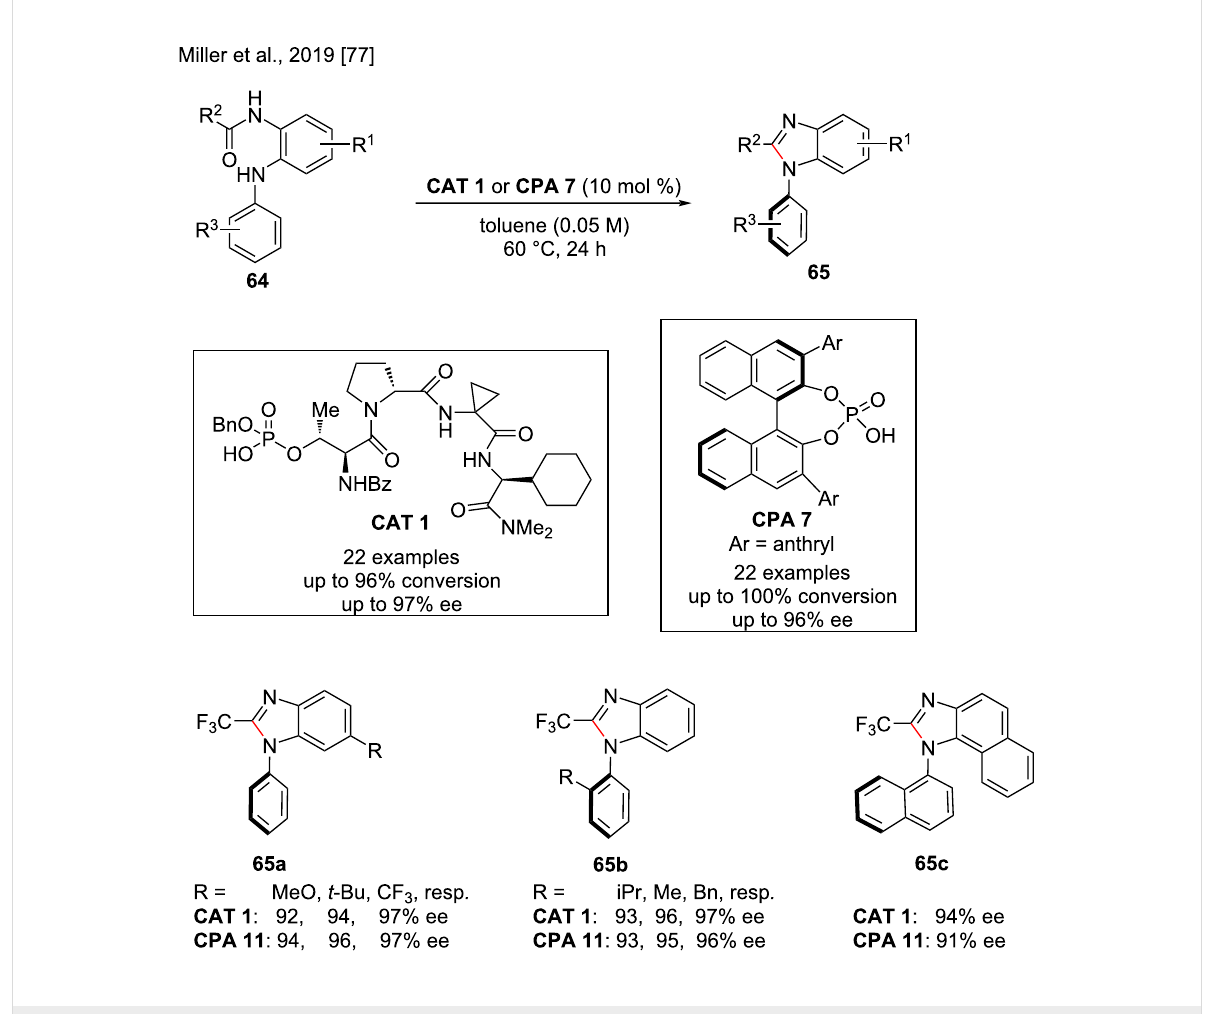
Scheme 21: Atroposelective cyclodehydration